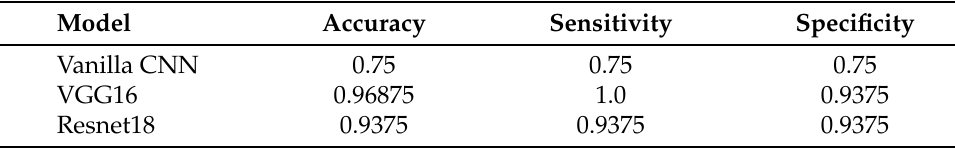
Table 2. Predictive metrics comparison for the three deep learning models.